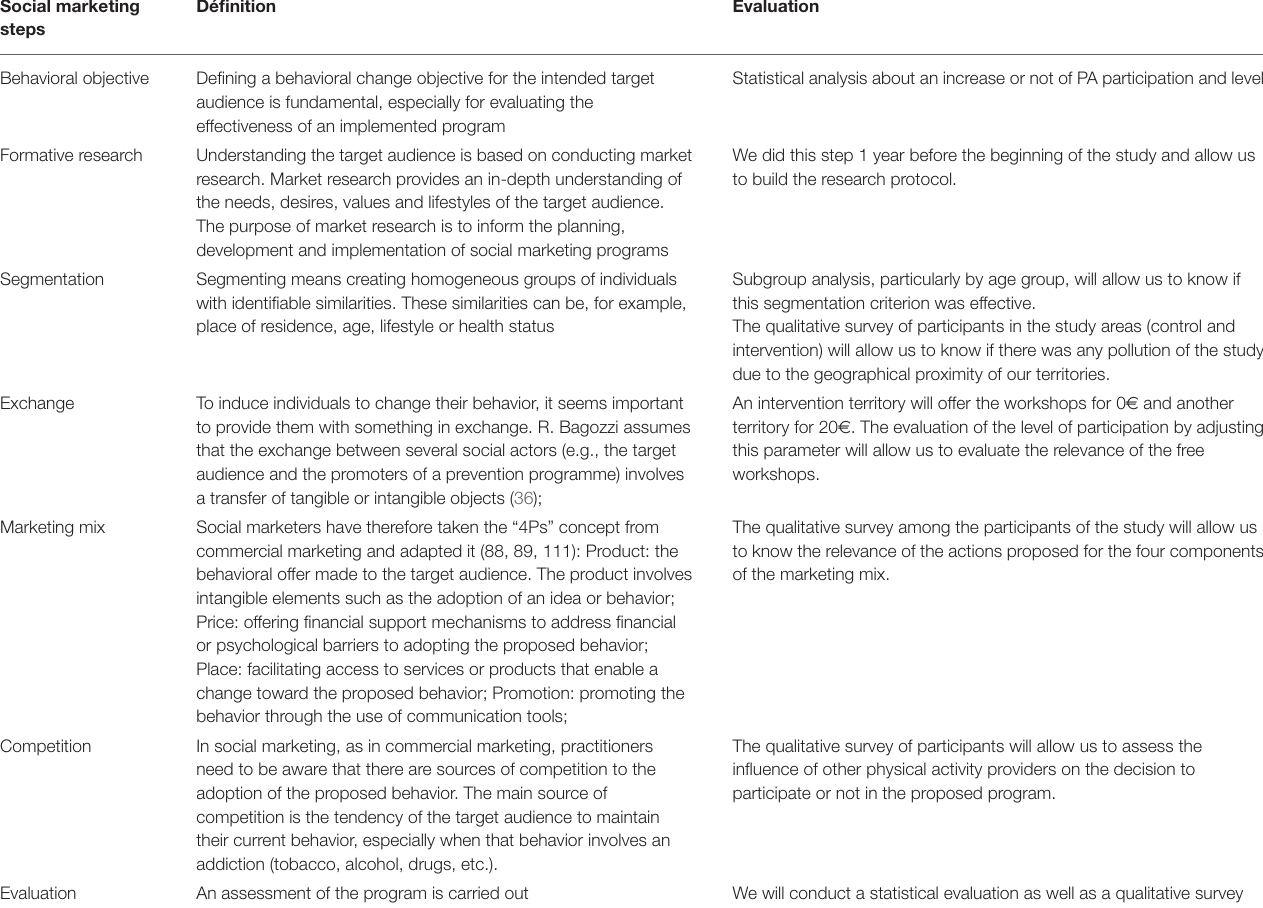
TABLE 1 | Definition and evaluation of each social marketing benchmark